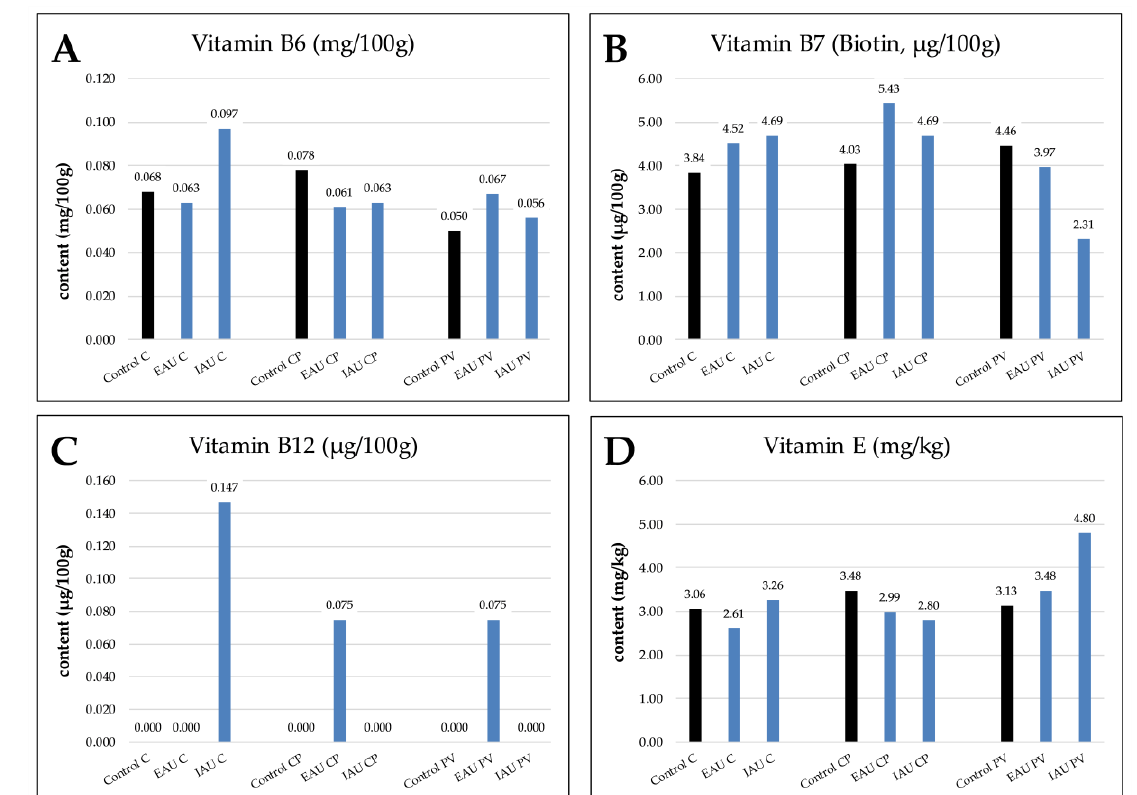
Figure 4. Wheatgrass contents of ( A ) vitamin B6, ( B ) vitamin B7 (biotin), ( C ) vitamin B12, and ( D ) vitamin E in different experimental groups (Control, extensive aquaculture unit (EAU), inten- sive aquaculture unit (IAU)); substrates are illustrated as coconut fibers 100% (C), coconut fibers 70% + perlite 30% (CP), and perlite 50% + vermiculite 50%